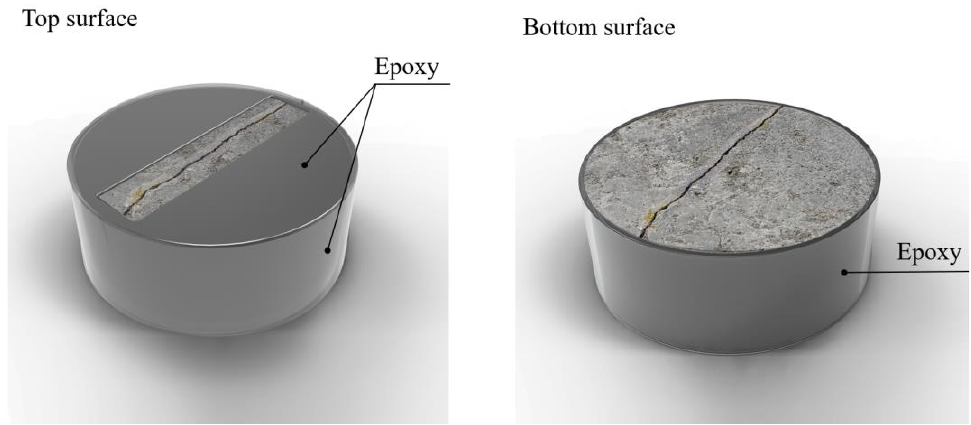
Figure 4. Epoxy coating of specimen.